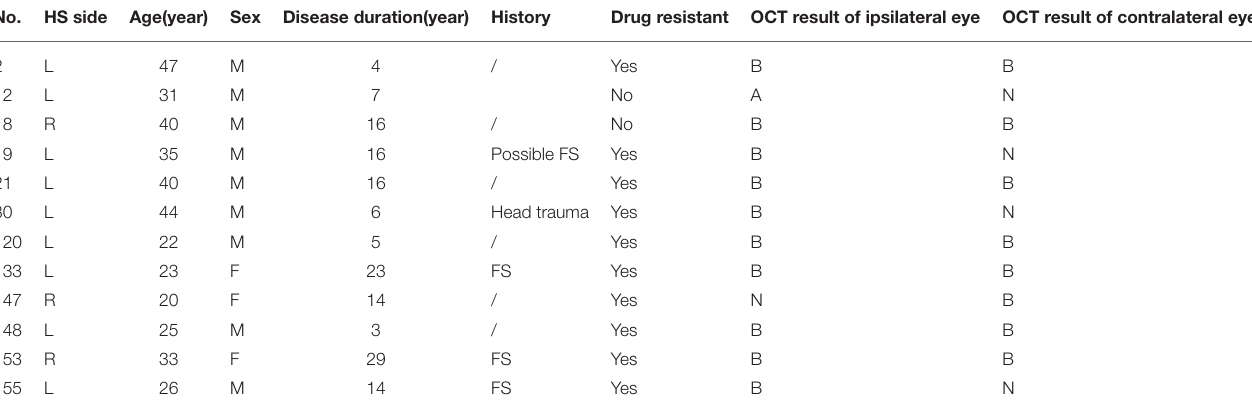
TABLE 3 | The abnormal/borderline thinning of average RNFL in individuals with HS. No. HS side Age(year) Sex Disease duration(year) History